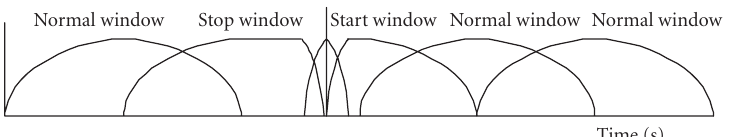
Figure 4: Schematic presentation of dynamic window switching in case of a transient. A stop window is placed just before the detected transient position. The transient itself is captured using a short